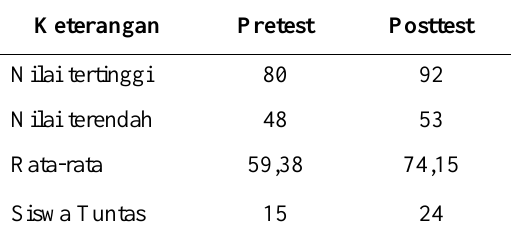
Tabel 2. Data Hasil Pretest dan Postest